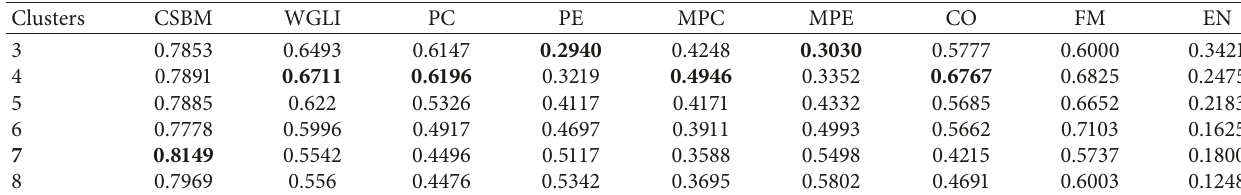
Table 7: Values of each index on the zoo dataset.